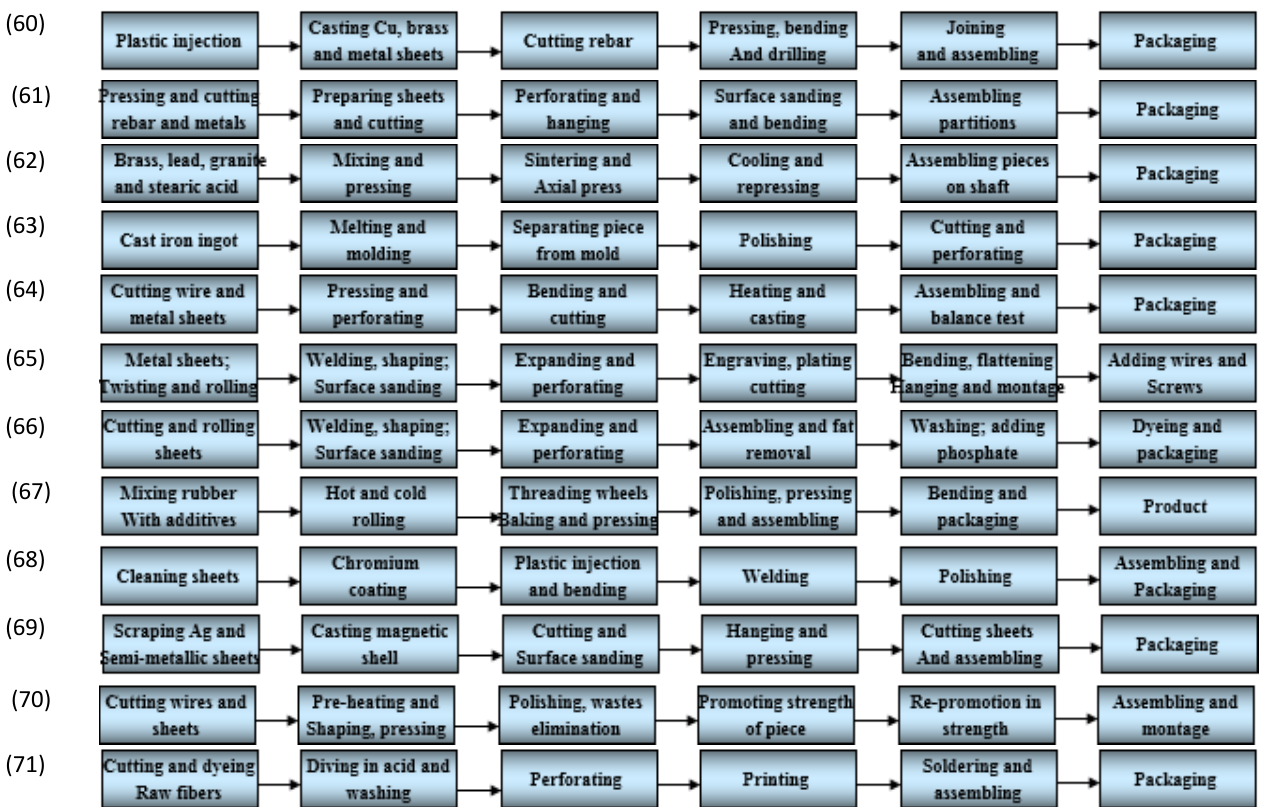
Figure 2. IAI and their generation